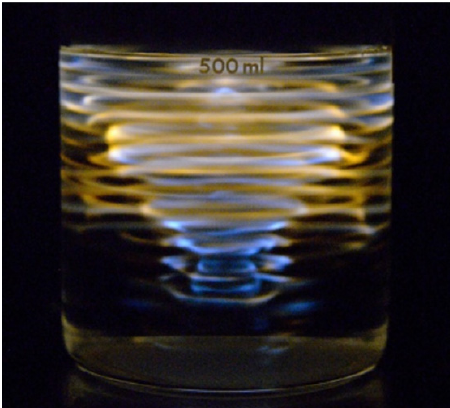
Figure 1. Photographic image of MBSL from Ar-saturated SDS solution at an acoustic power of 4 W [3]. Ultrasound at a frequency of 148 kHz was irradiated from the bottom of the beaker. Copyright 2015, with the permission from Elsevier.